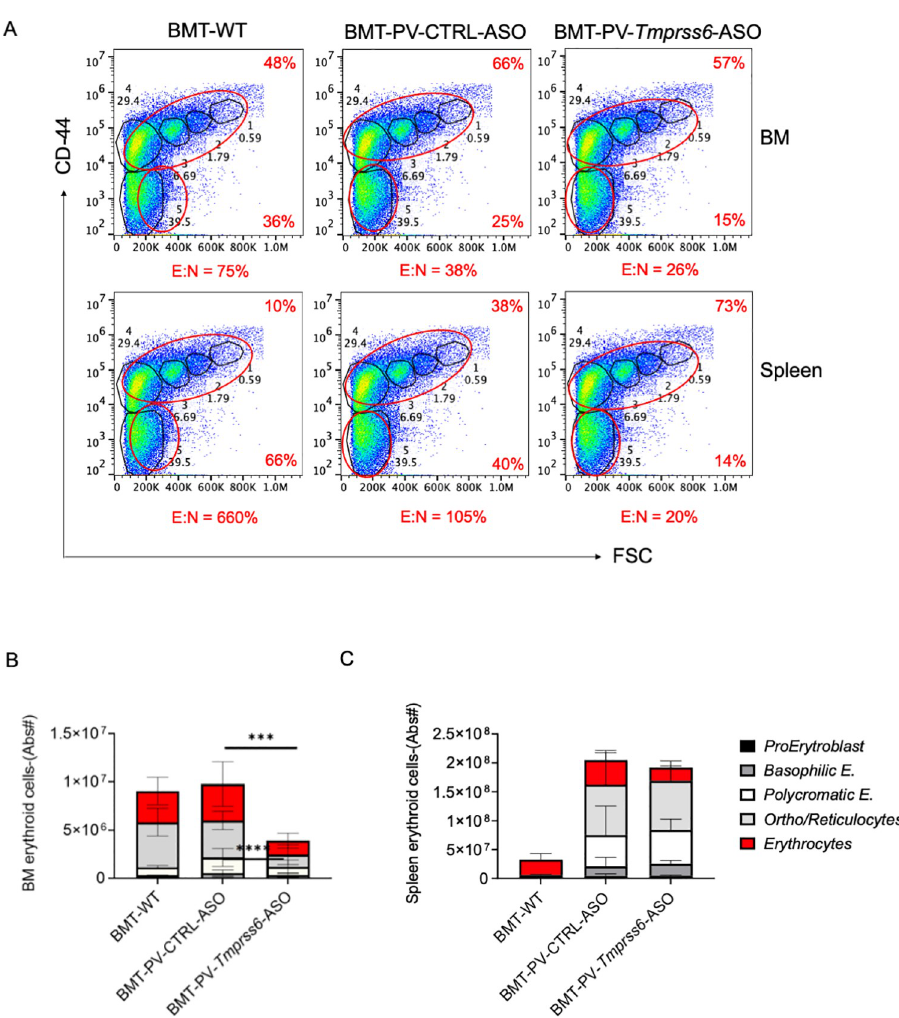
Fig 2. Tmprss6 -ASO reduced erythropoiesis in the bone marrow of PV mice. Flow cytometry analysis of bone marrow and spleen (A) showed signs of iron restricted erythropoiesis as indicated by decreased erythroblast maturation with a decreased ratio of enucleated:nucleated (E:N) cells, consistent with more ineffective erythropoiesis. Flow cytometry analysis of the five clusters of erythroid populations shows significant evidence of decreased erythroblast differentiation in the BM (orthochromatic erythroblasts /reticulocytes, and mature red cells) (B), while only a trend can be appreciated in the spleen (mature red cells) ( C ). For these analyses were used BMT-WT mice (n = 3), BMT-PV-CTRL-ASO mice (n = 6), and BMT-PV- Tmprss6 -ASO mice (n = 7). Results represent mean ± SD. Bars represent standard deviation (SD). 2-way ANOVA (with Tukey’s multiple comparisons tests) was used for the statistical analysis. Asterisks refer to statistically significant differences: ���� P � 0.001, ��� P � 0.005. Only statistical differences between BMT-PV-Ctrl-ASO and BMT-PV- Tmprss6 -ASO mice are indicated in the graphs.